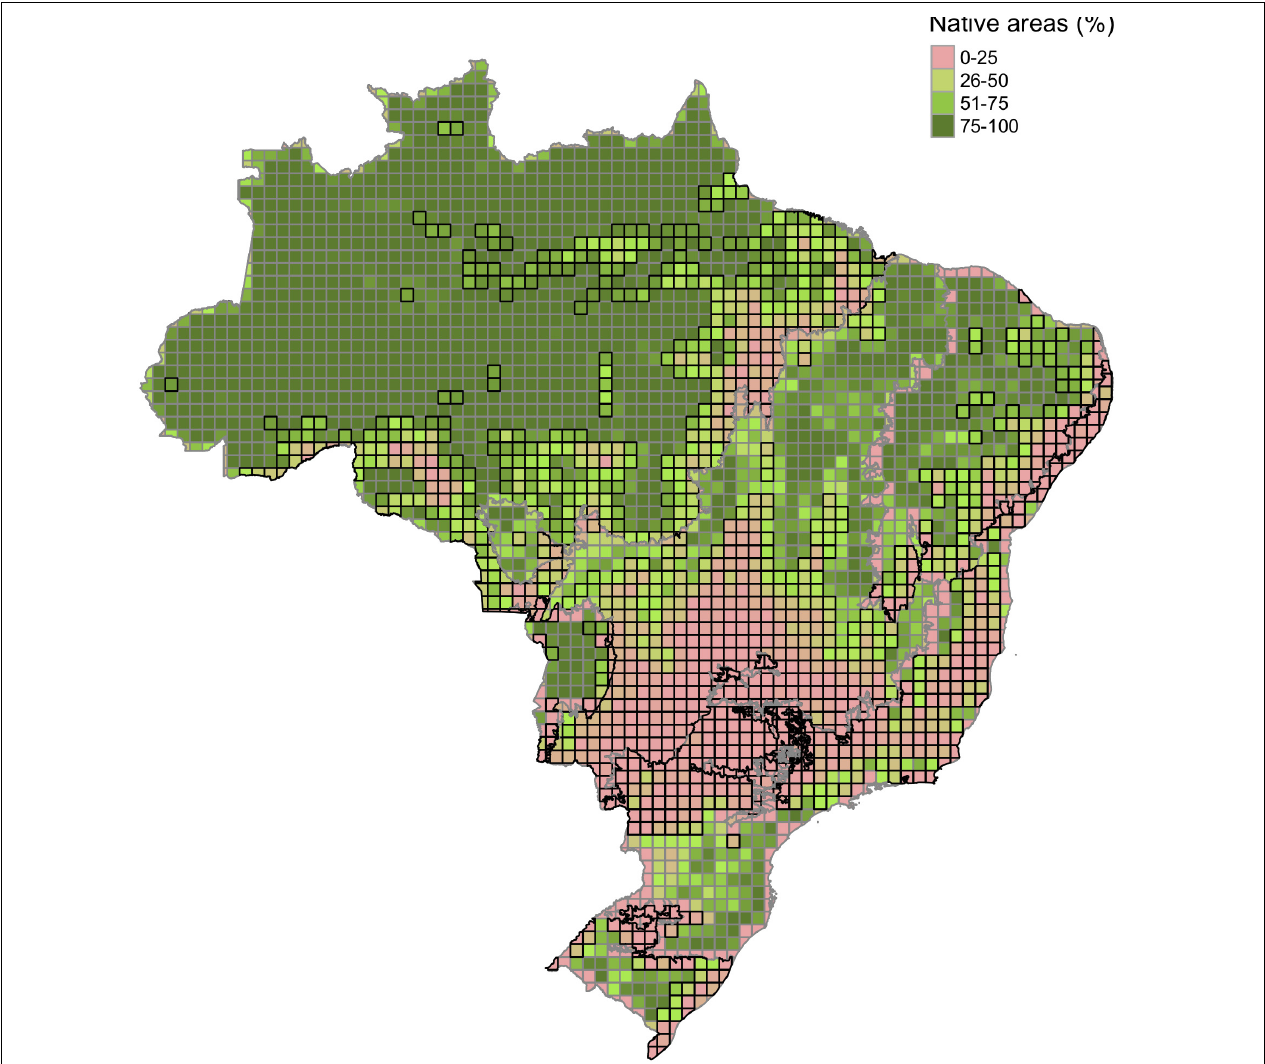
FIGURE 4 | Natural vegetation remaining areas and the cells with loss of Ecosystem Service (ES) greater than the average of the biome. Ecosystem services include all guilds (carnivores, frugivores, insectivores, and nectarivores).